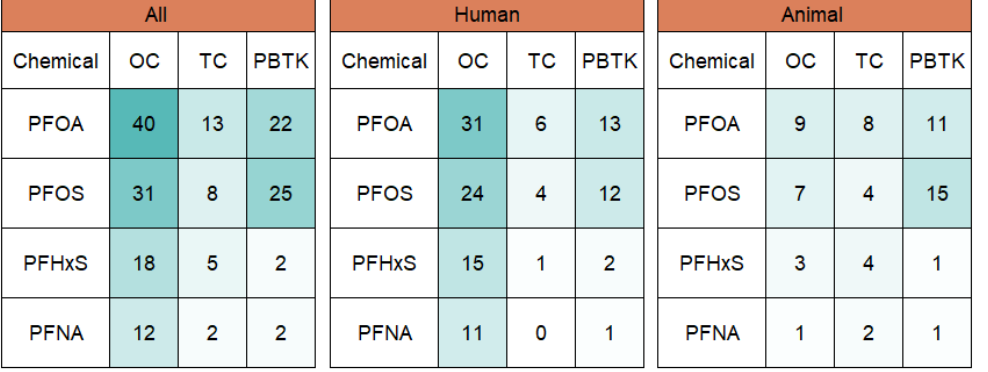
Figure 3. Chemical and TK model type by organism facet for the four most studied PFAS. Note: OC = One Compartment, TC = Two Compartment, PBTK = Physiologically Based Toxicokinetic.